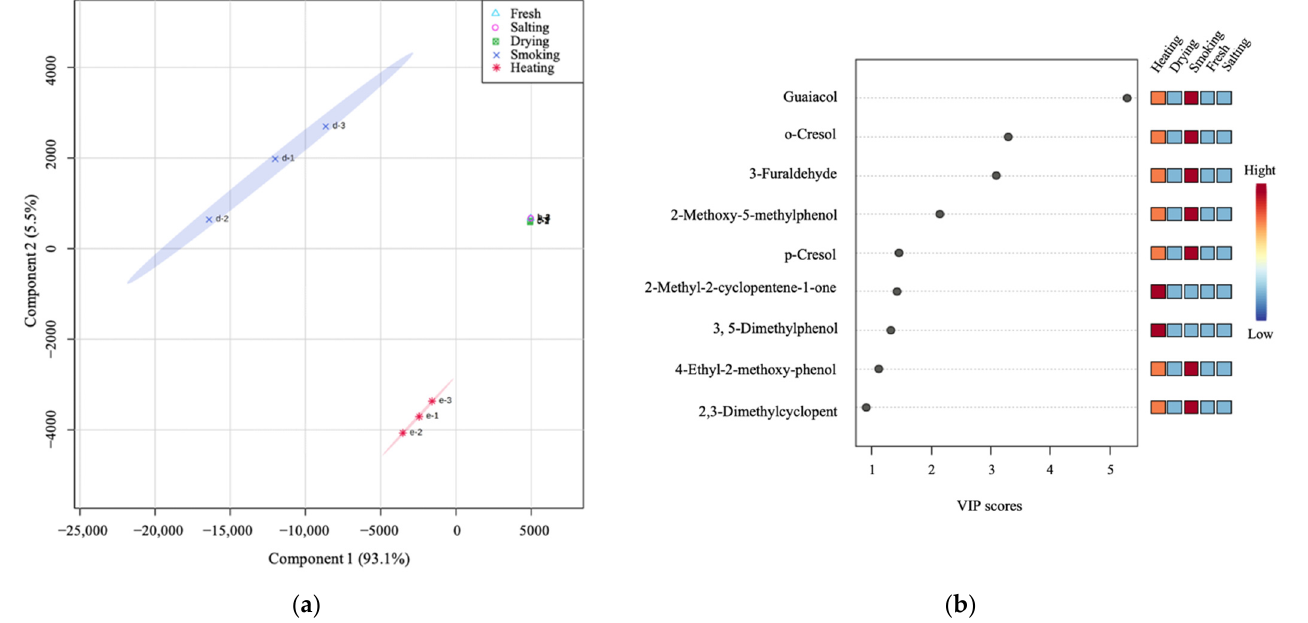
Figure 3. PLS-DA and the important flavors (VIP ≥ 1.0) for smoke-flavored sea bass at different production steps. ( a ) PLS-DA scores scatter plot. ( b ) Important volatiles (VIP ≥ 1.0) identified by PLS-DA. The colored boxes on the right indicate the relative concentrations of the corresponding volatiles at different stages.